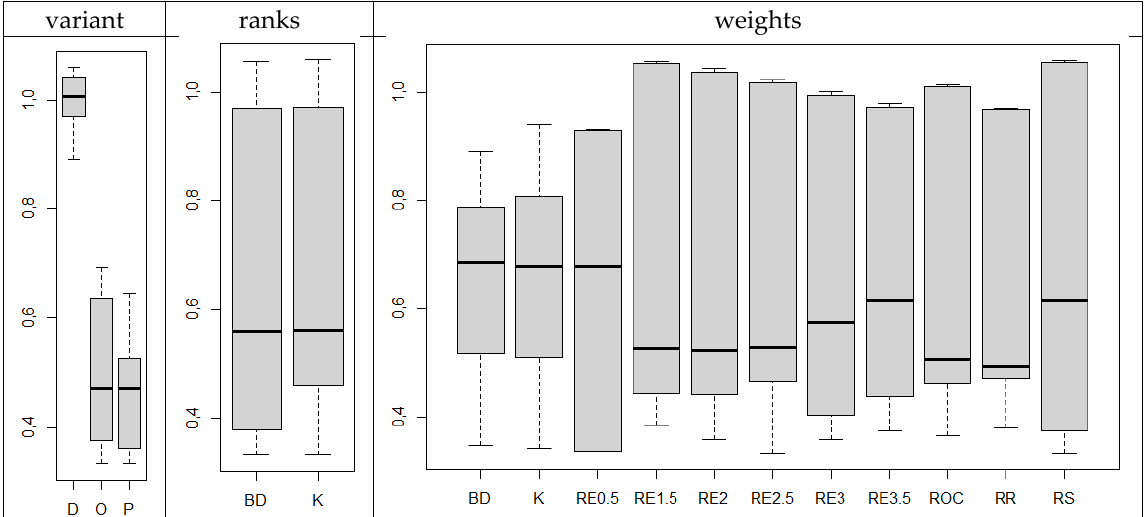
Figure 8. Distance distributions 𝑑 (𝐾𝑃𝐼′ 1 , 𝐾𝑃𝐼′ 2 ) according to the approaches used in the construction of indicators. Source: authors’ own material based on the GUS data.